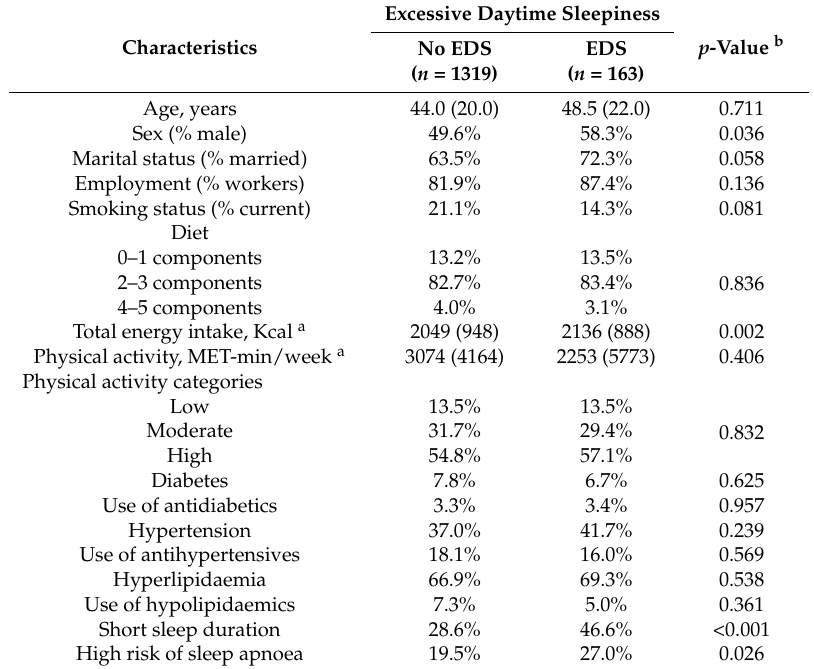
Table 3. Characteristics of study population by excessive daytime